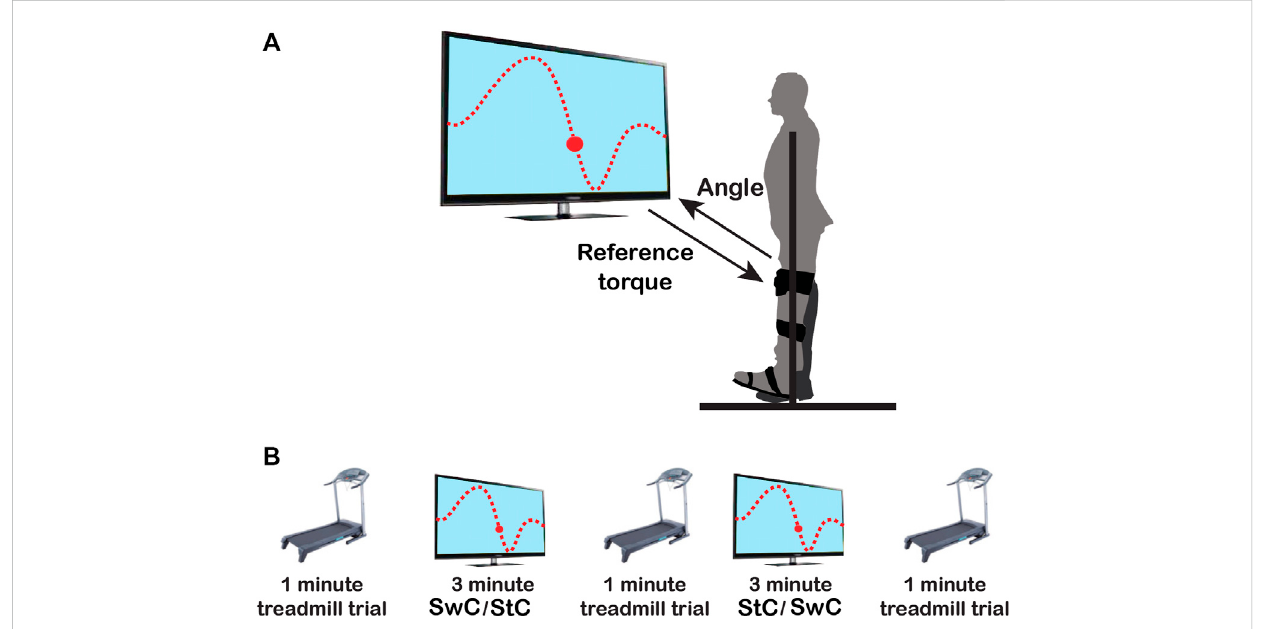
FIGURE 2 Schematics of the experimental protocol. (A) The upper panel shows the experimental setup. Subjects ’ dominant ankle had to follow the up- downwardsmovement presented on the screen as a dotted line, mimicking thenormalankle pattern in thesagittal plane during gait. (B) The lower panel showstheorderoftrialsalongthesession:1)1-mintreadmilltrial;2)StCorSwCtrial,forthreeminutes;3)1-mintreadmilltrial;4)SwCorStCtrial,forthree minutes; and 5) last 1-min treadmill trial. Periods of fi ve minutes of rest between sessions were included to avoid muscle fatigue.